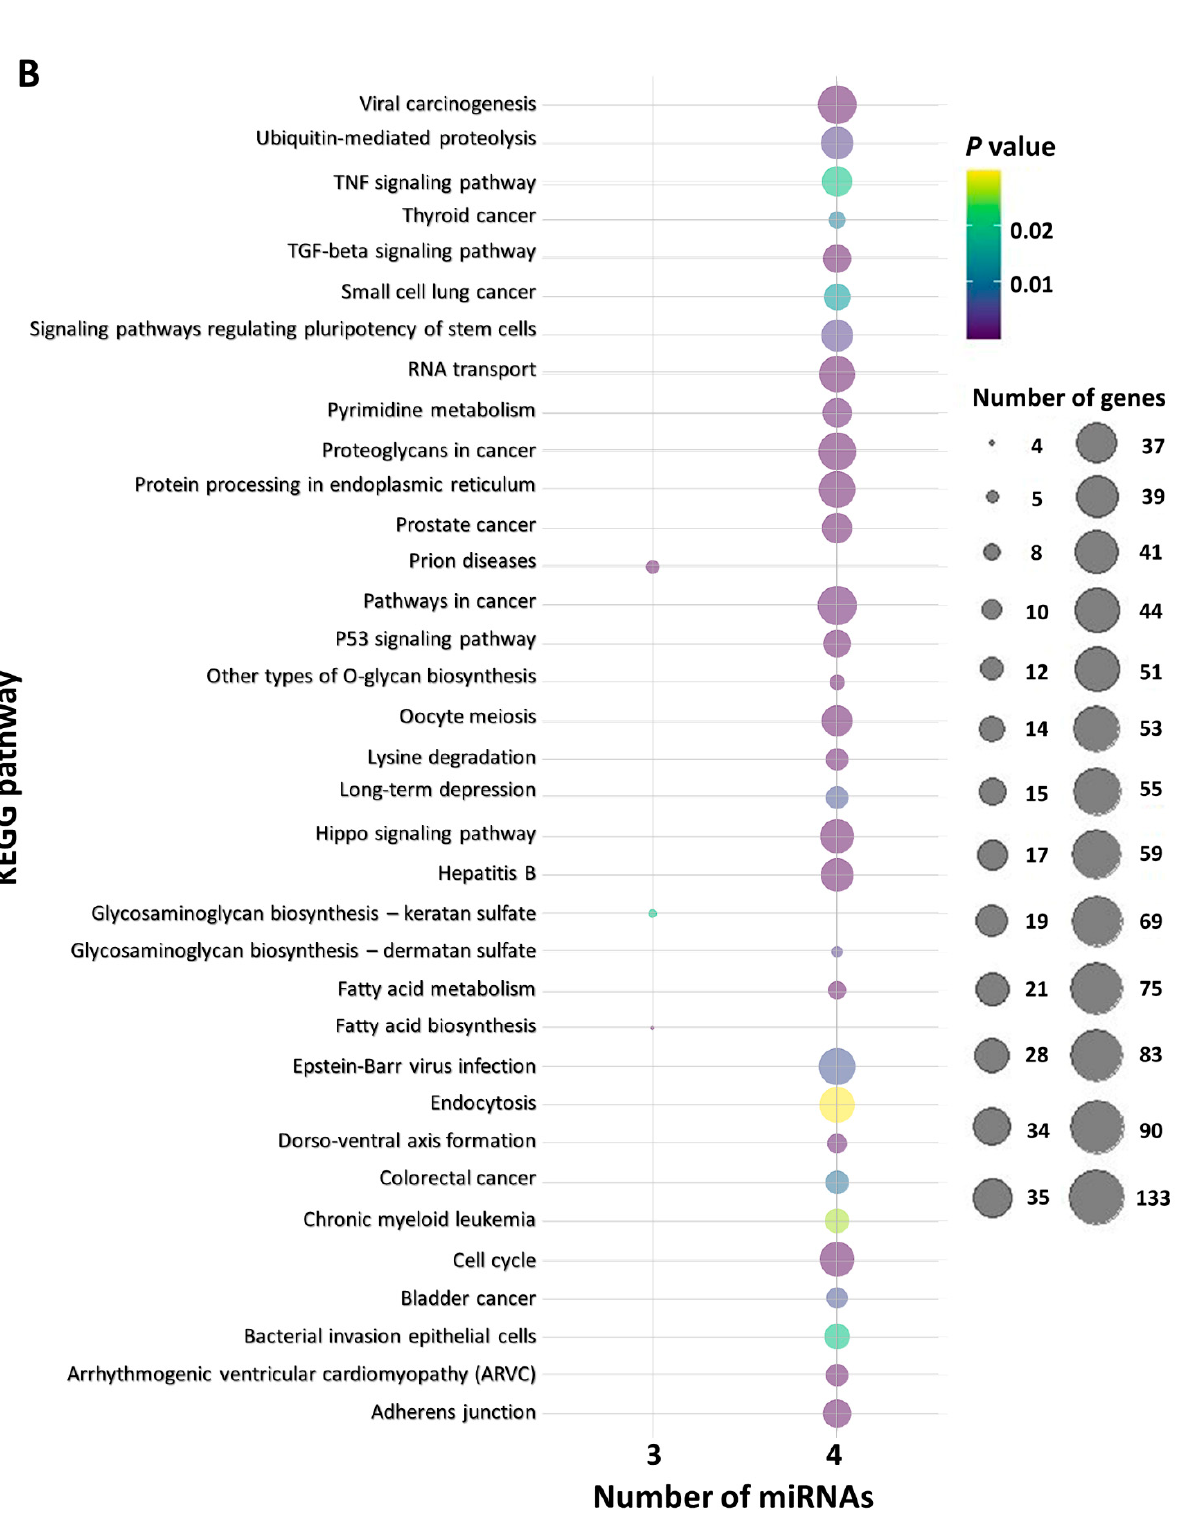
Figure 5. The KEGG pathways in which miR-16-5p, miR-155-5p, and miR-223-3p ( A ) as well as miR-15a-5p, miR-16-5p, miR-125b-5p, and miR-222-3p ( B ) possibly participate. The size of each bubble shows the number of miRNA targets related to each pathway, while the color of the bubble indicates the likelihood of the implication in each pathway.